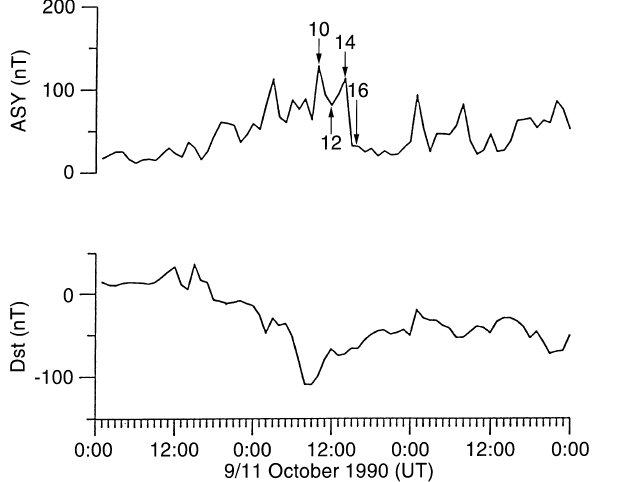
Fig. 2. Dst and ASY values of the geomagnetic X -component on 9–11 October 1990